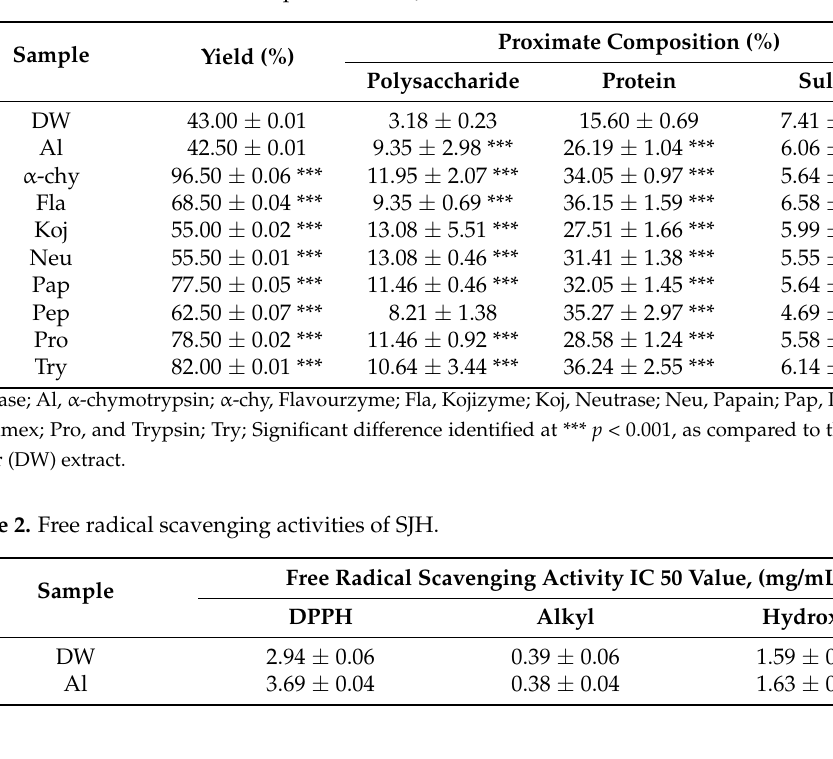
Table 1. Yields and chemical compositions of SJH.